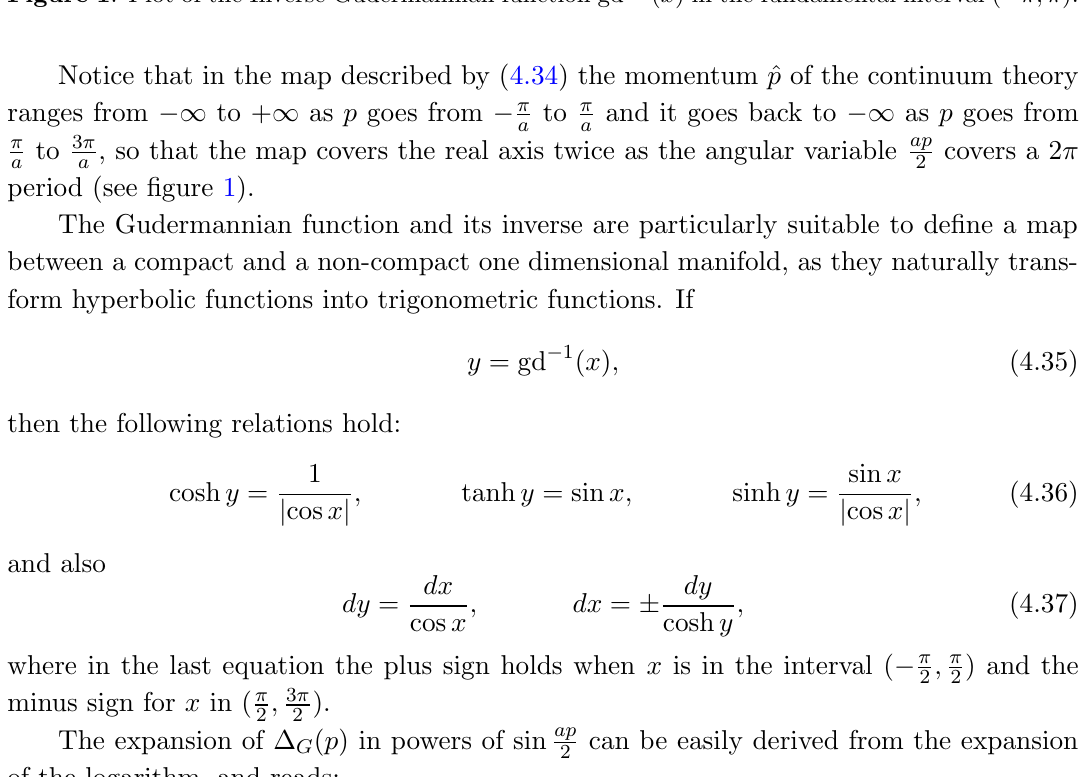
to (cid:25) and it goes back to (cid:0)1 as p goes from a a